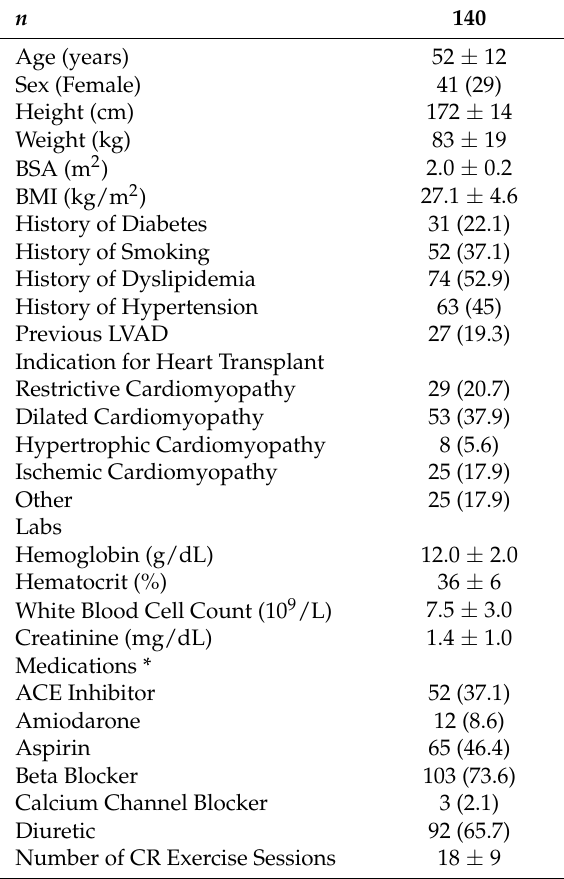
Table 1. Recipient demographics and clinical